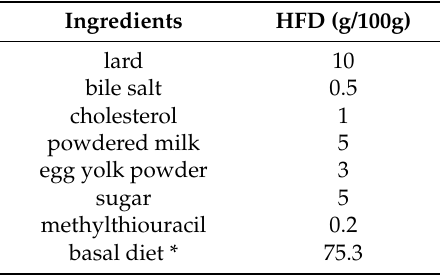
Table 1. The composition of experimental